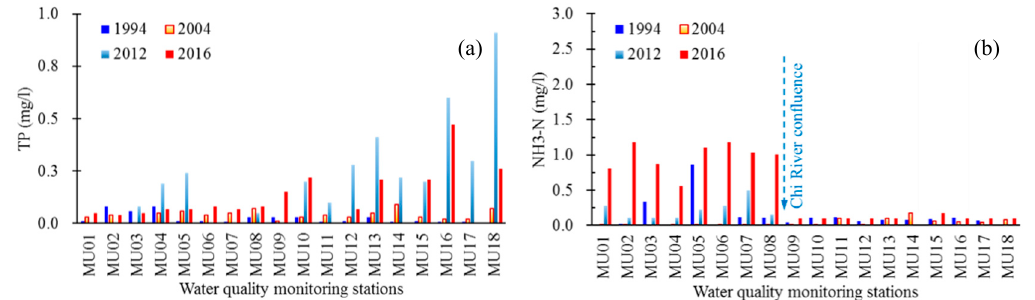
Figure 5. Variation of total phosphorus (TP) ( a ) and NH 3 -N ( b ) values along the Mun River in the dry season (May) of selected years.